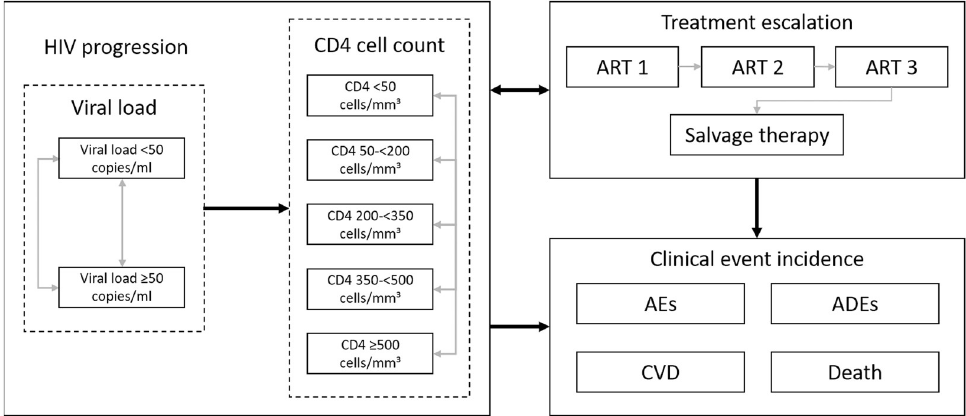
Fig 1. Model flow diagram. Abbreviations: ADE: AIDS defining event; AE: adverse event; ART: antiretroviral therapy; CD4: cluster of differentiation 4; CVD: cardiovascular disease.